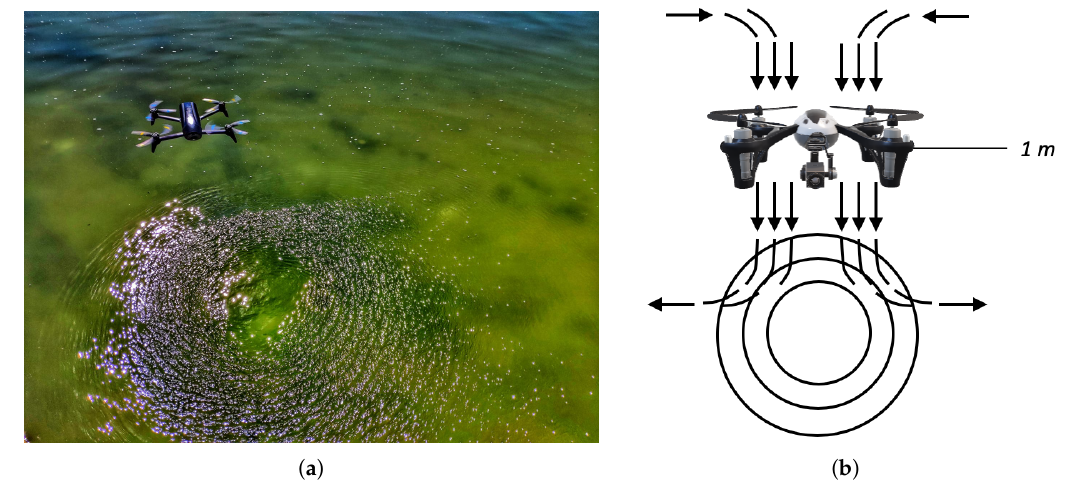
Figure 1. Downwash Effect: ( a ) In water terrain; ( b ) The